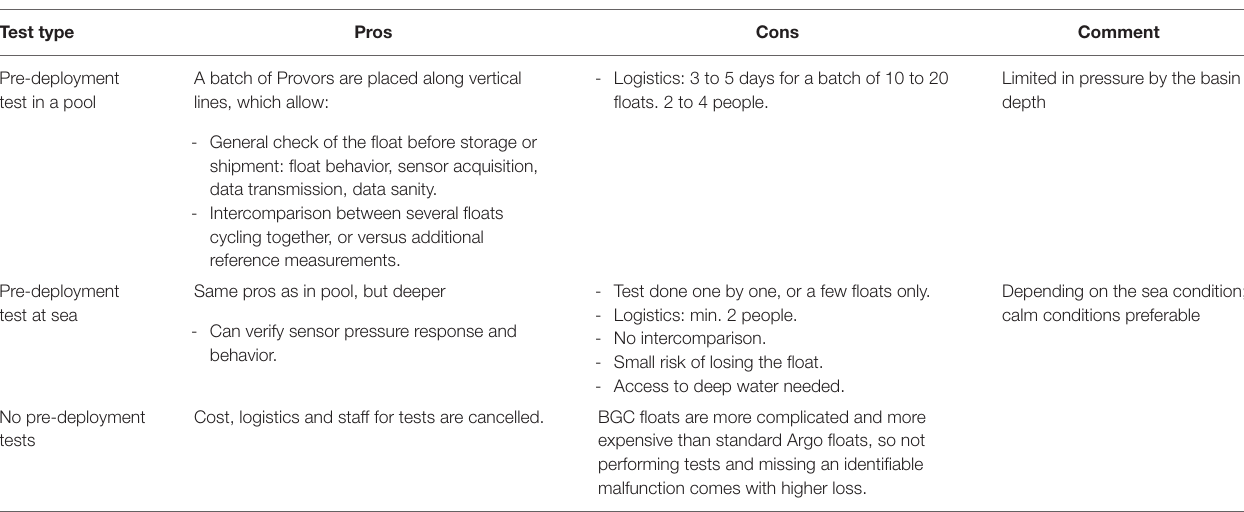
TABLE 4 | Comparison of float test deployment options with pros and cons based on Ifremer experience. Test type